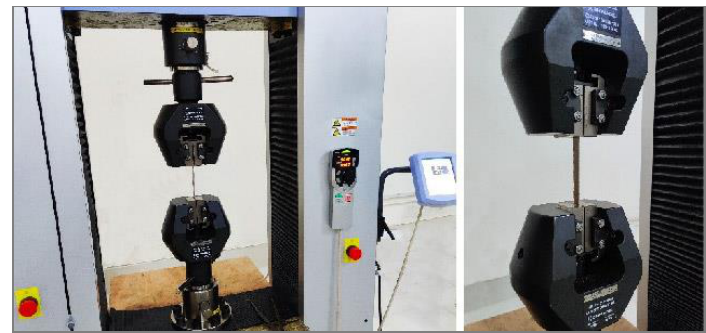
Figure 3. Tensile specimen setup in universal testing machine.